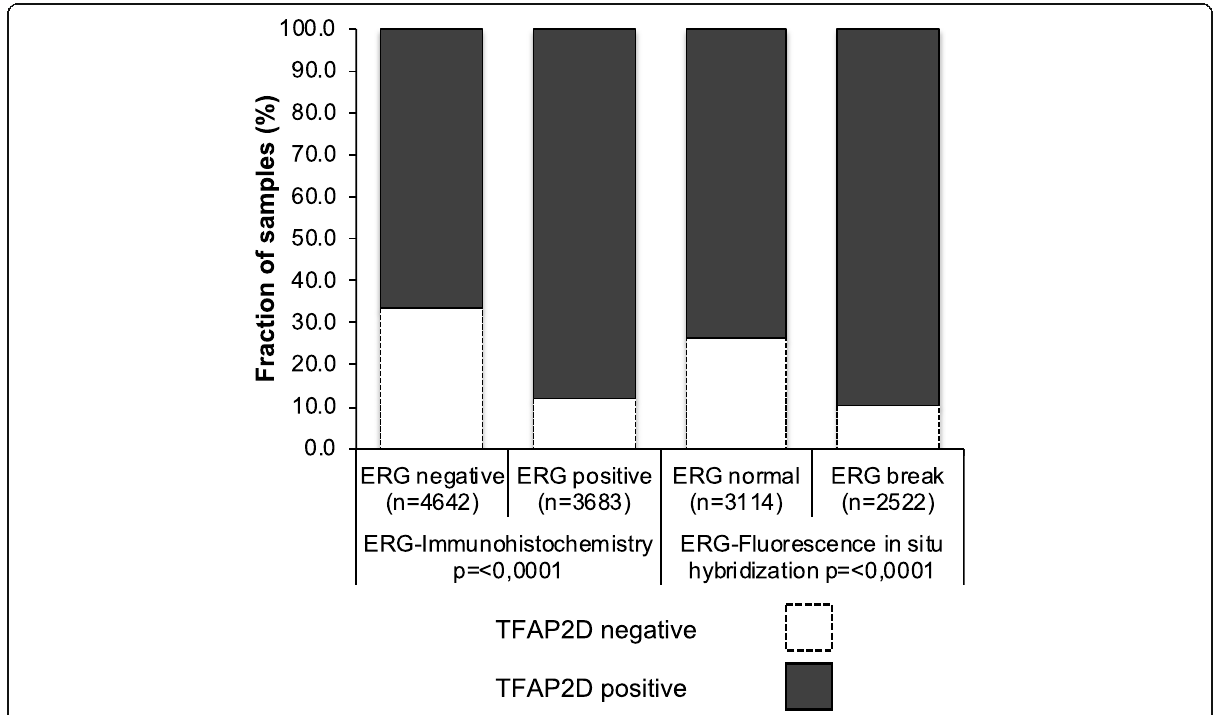
Fig. 2 Association between positive TFAP2D immunostaining and ERG-status (IHC/FISH) in all